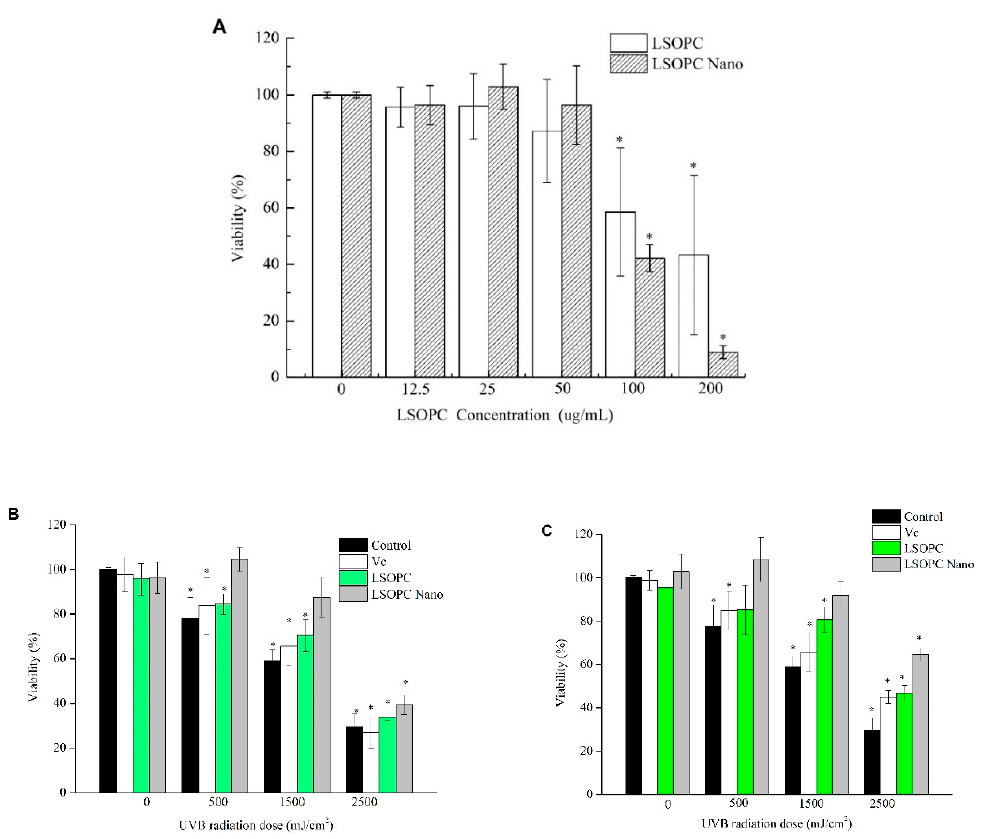
Figure 4. Cytotoxic e ff ects of di ff erent concentrations of LSOPC and LSOPC Nano ( A ); protective e ff ects of Vc, LSOPC, and LSOPC Nano on human foreskin fibroblast cell (HFF-1) after ultraviolet B (UVB) irradiation; the concentrations of Vc, LSOPC, and LSOPC Nano were as follows: ( B ) 12.5 µ g / mL; ( C ) 25 µ g / mL. * p <